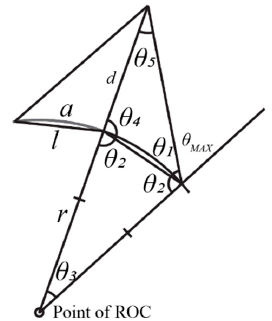
Figure 7. The various angles are labeled as “ 𝜃 _”. Half of the aperture is labeled “a”, and the secant under the arc is “l”. The maximum deflection from the normal is required at either end of the shaped beam and is defined, for this paper, as 𝜃 (cid:3014)(cid:3002)(cid:3025) = 2° . The figure is not drawn to scale, in order to improve viewability.